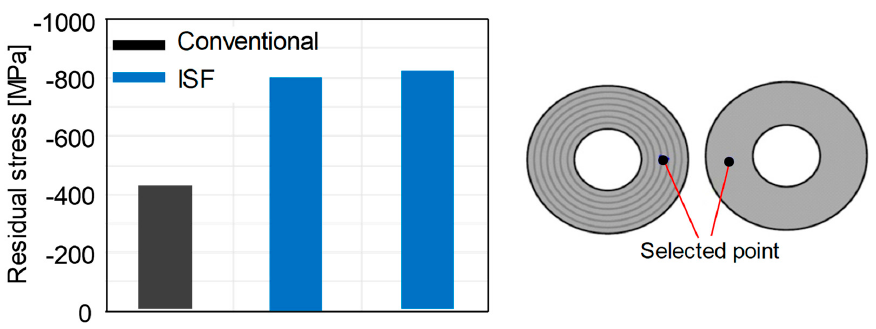
Figure 11. Repeatability of the residual stresses measured by X-ray diffraction (XRD) in conventional and incrementally formed disc springs from steel B under the same set of process parameters.